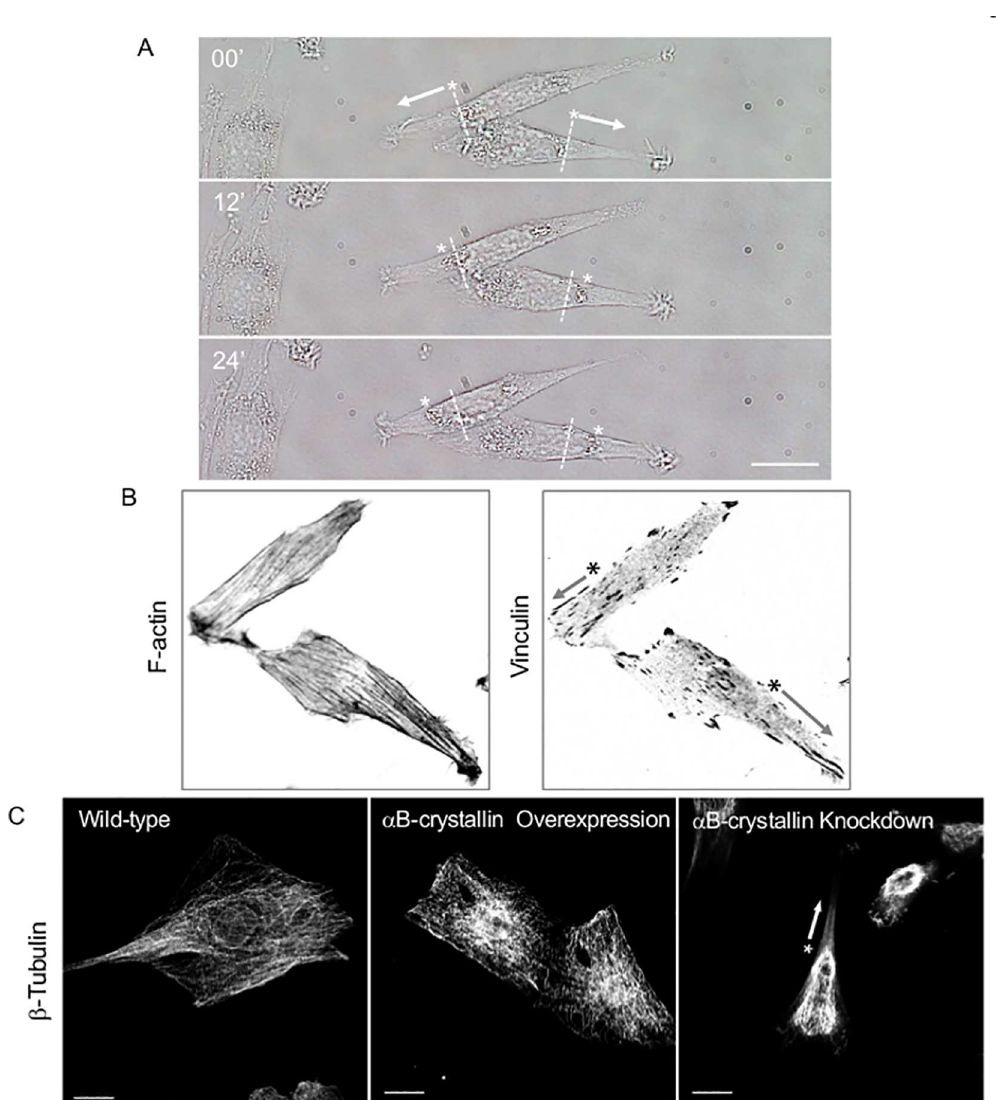
Fig 12. Time-lapse imaging of α B-crystallin knockdown L6 cells. Directional cell migrationas fast as about 10 μ m/ h are typically seen. Positionof the nuclei are indicatedby asterisks and arrows indicatethe migratory direction. Bar is 20 μ m (A). Asymmetric distributionof nucleus,F-actin stress fiber, and focal adhesionof α B- crystallin knockdown cells (B, invertedcontrast image of Fig 11) are coincidewith asymmetric polymerization of microtubule caused by α B-crystallin knockdown. Bar is 20 μ m